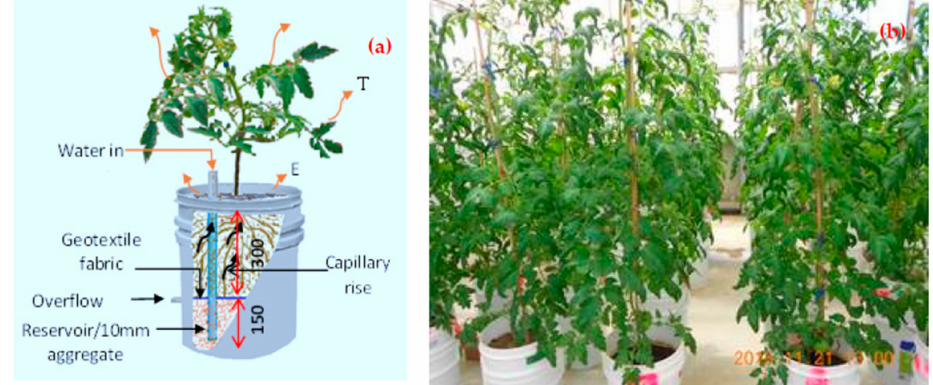
Figure 1. ( a ) Schematic arrangement of the wicking bed, ( b ) photograph of plants growing inside glasshouse during the